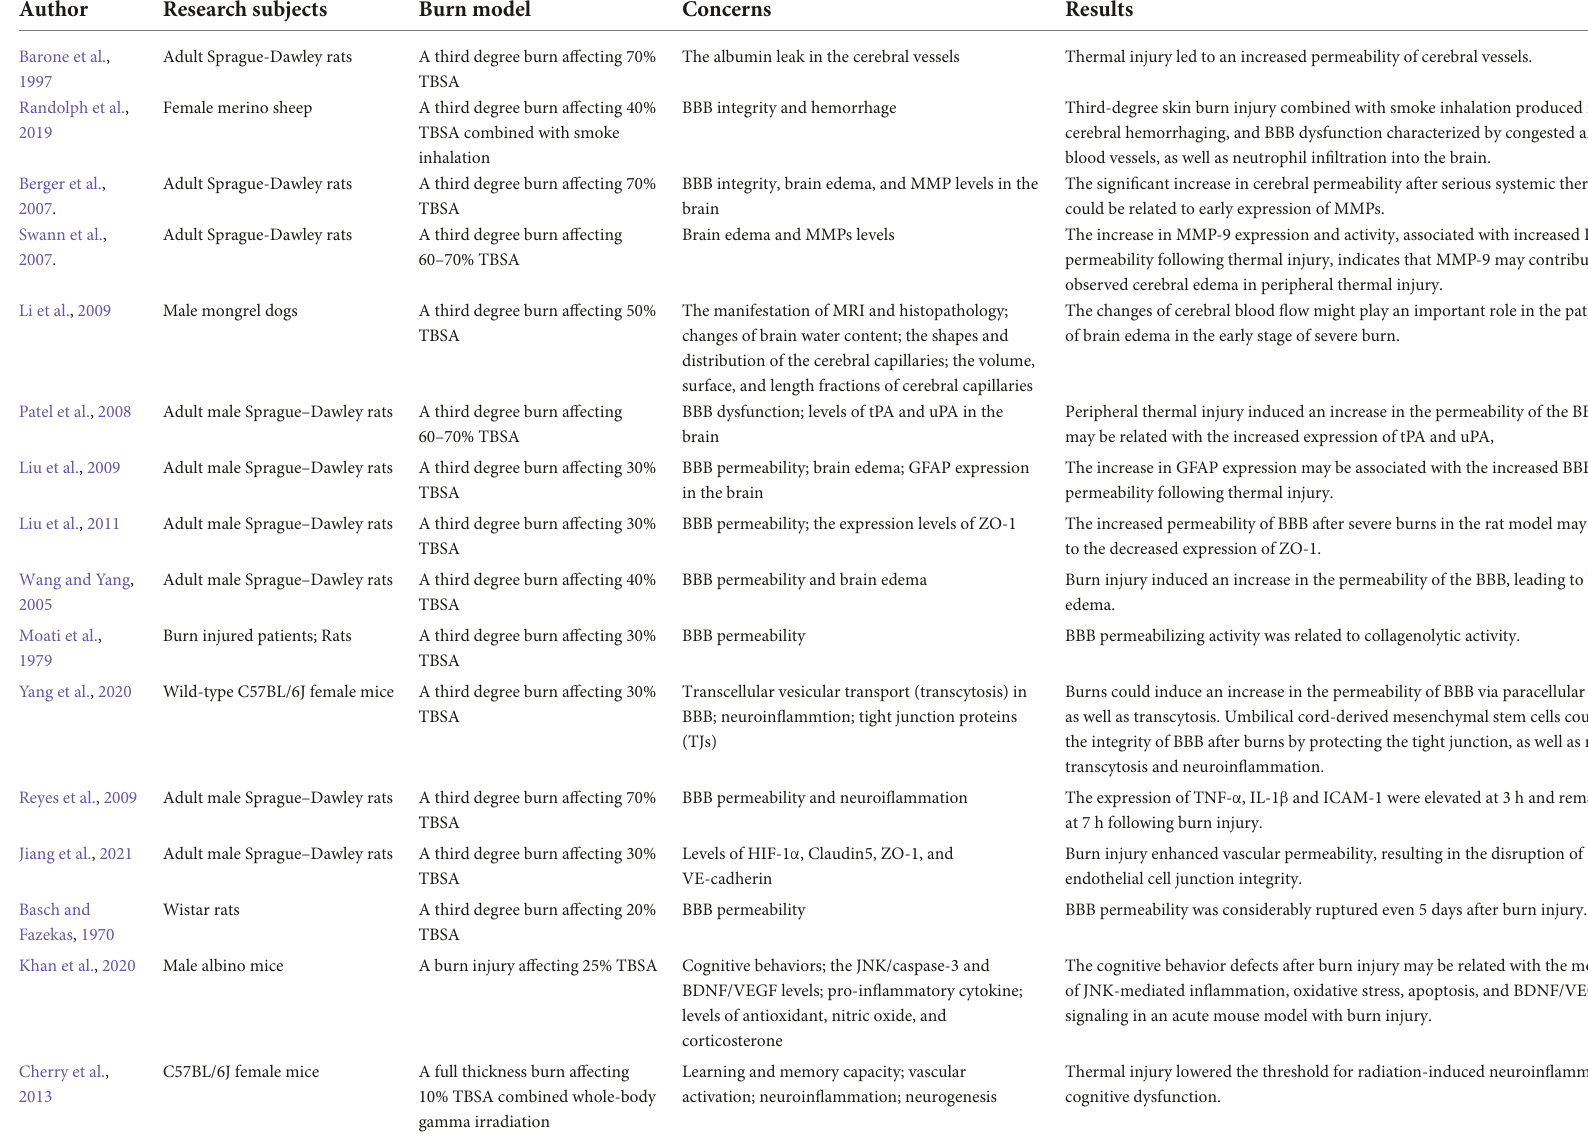
TABLE 1 Researches related to the blood-brain barrier dysfunction after burn